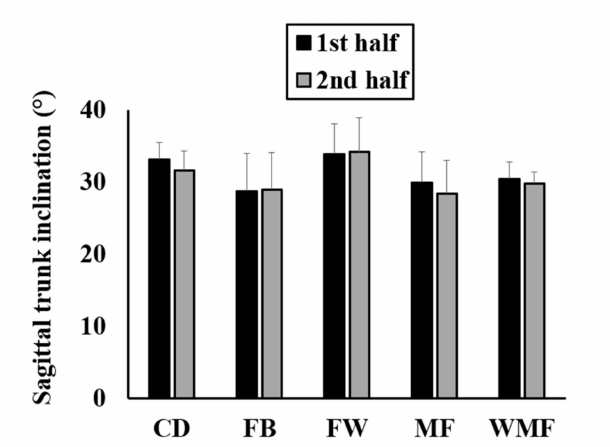
Figure 4. Sagittal trunk inclination of elite soccer players based on playing position and match